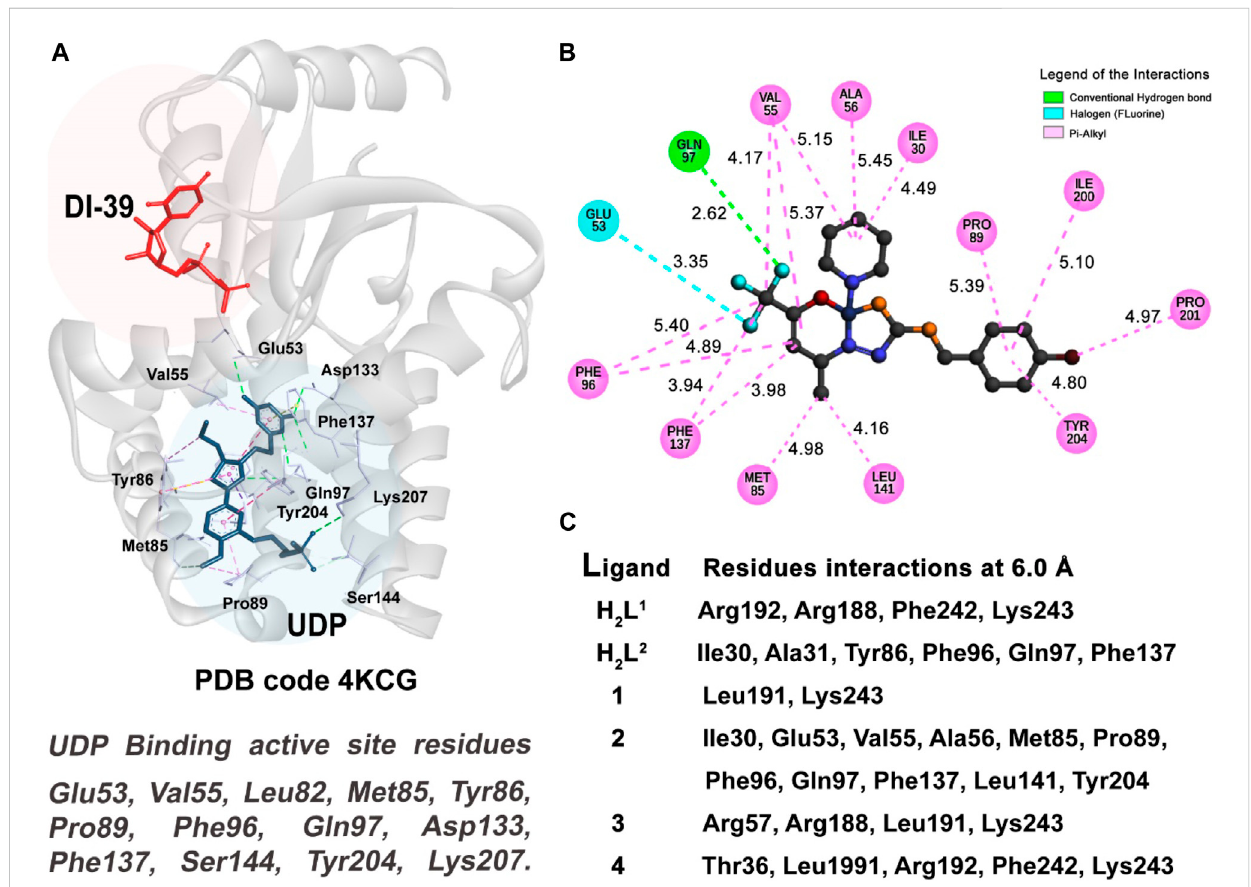
FIGURE 13 Molecular docking results of NALM-6 target. (A) Active site regions of UDP and DI-39 inhibitors and main residues of the DCK protein ( 4KCG ) (Nathanson et al., 2014). (B) 2D representation of the interactions carried out between the best-ranked inhibitor, 2 , and the UDP active site. (C)